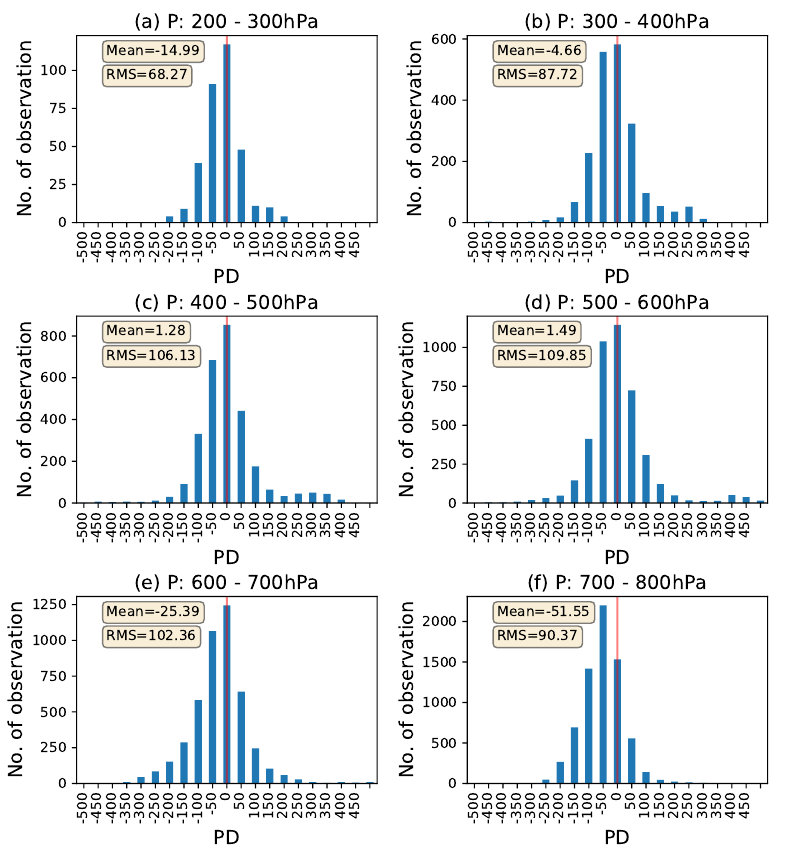
Figure 5. Histograms of PD for GK2A IR winds derived using the EBBT height assignment method at each pressure band during winter. Mean and RMS values of PD are presented. The red lines indicate that PD is zero.